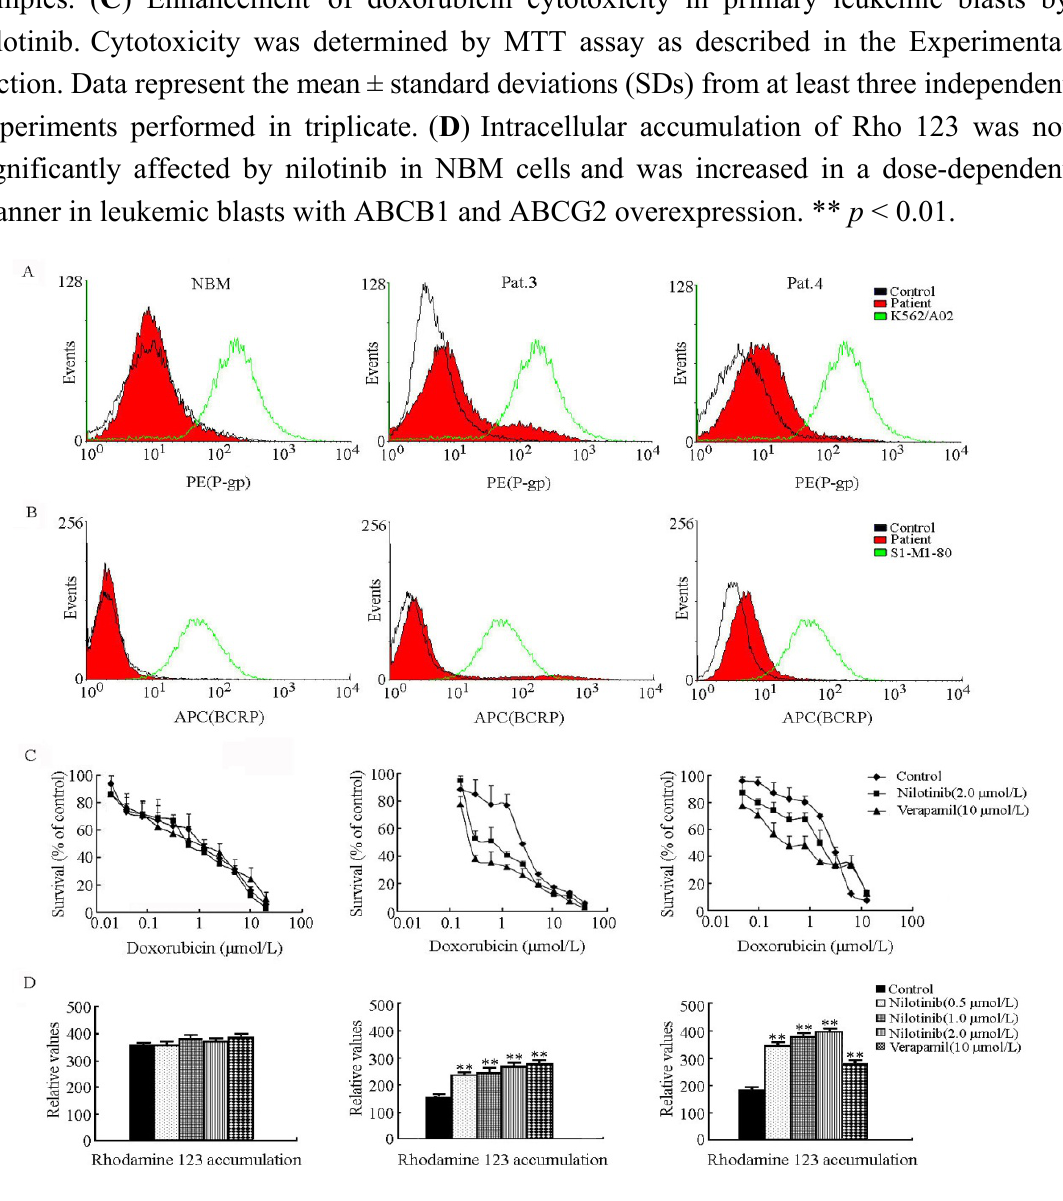
Figure 3. Nilotinib enhanced the cytotoxicity of doxorubicin and the intracellular accumulation of Rho 123 in primary leukemic blasts with ABCB1 and ABCG2 overexpression. Mononuclear cells were isolated as described in the Experimental